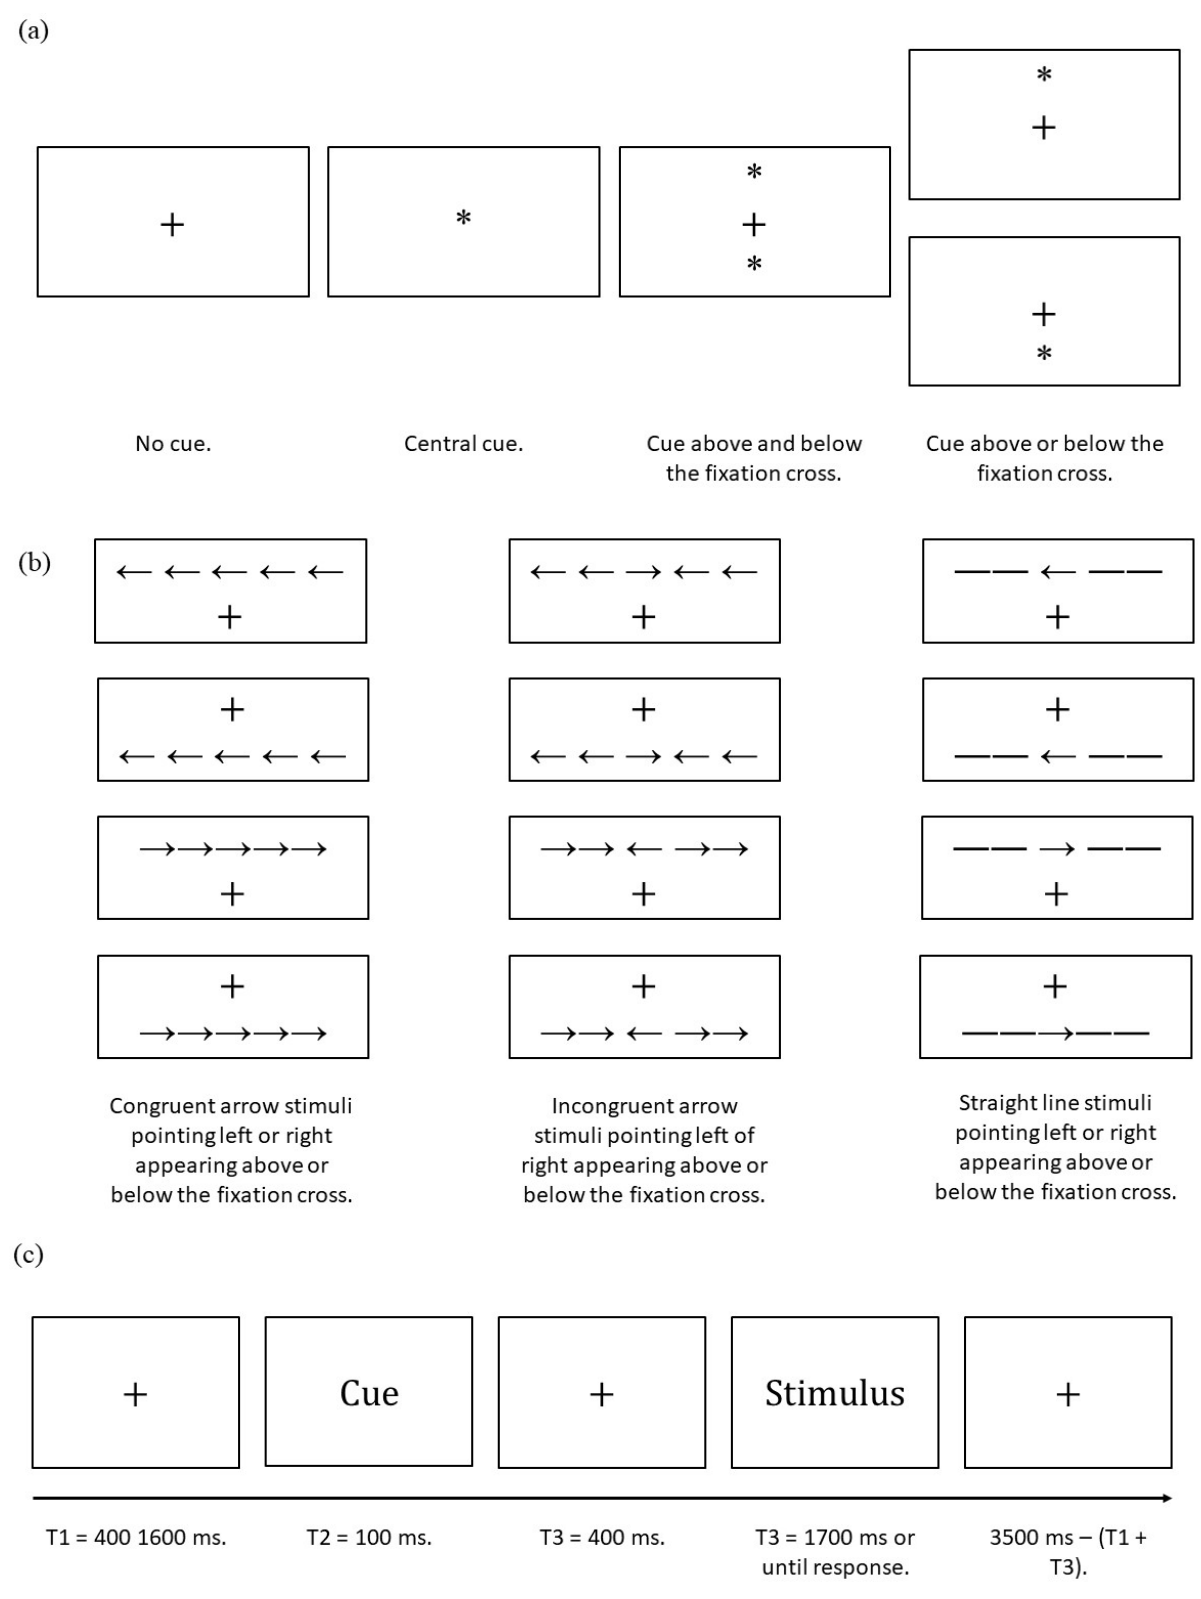
Figure 1. Schematic representation of the attentional networks test [27]; ( a ) all possible cues; ( b ) all possible stimuli; ( c ) timeline (ms = milliseconds; T = time).